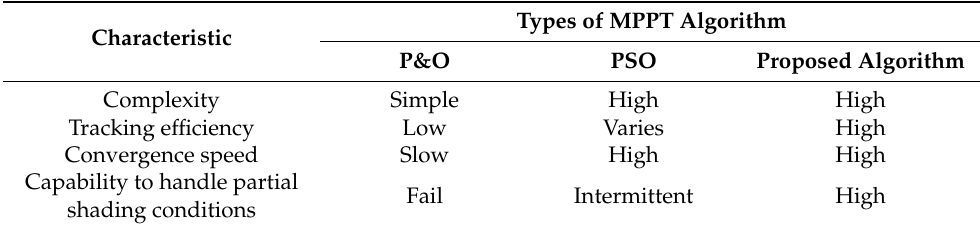
Table 6. Comparison between P&O, PSO, and the proposed